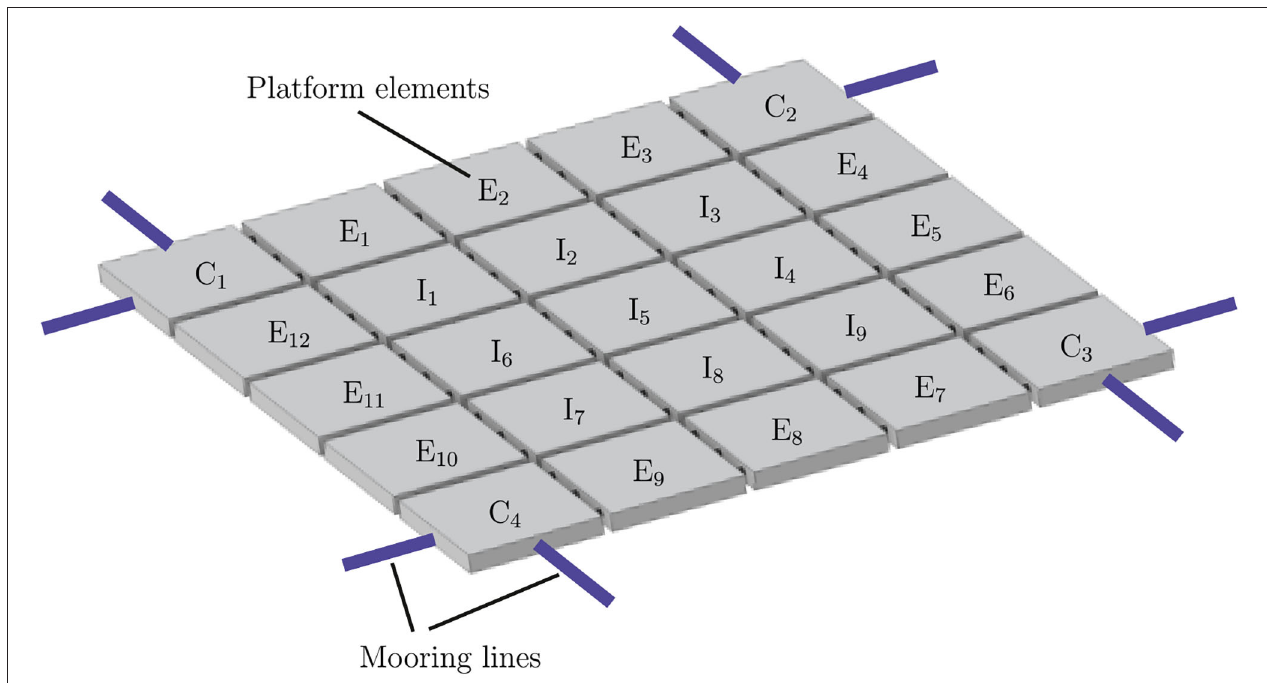
FIGURE 1 | Platform arrangement of 25 connected platforms and eight mooring